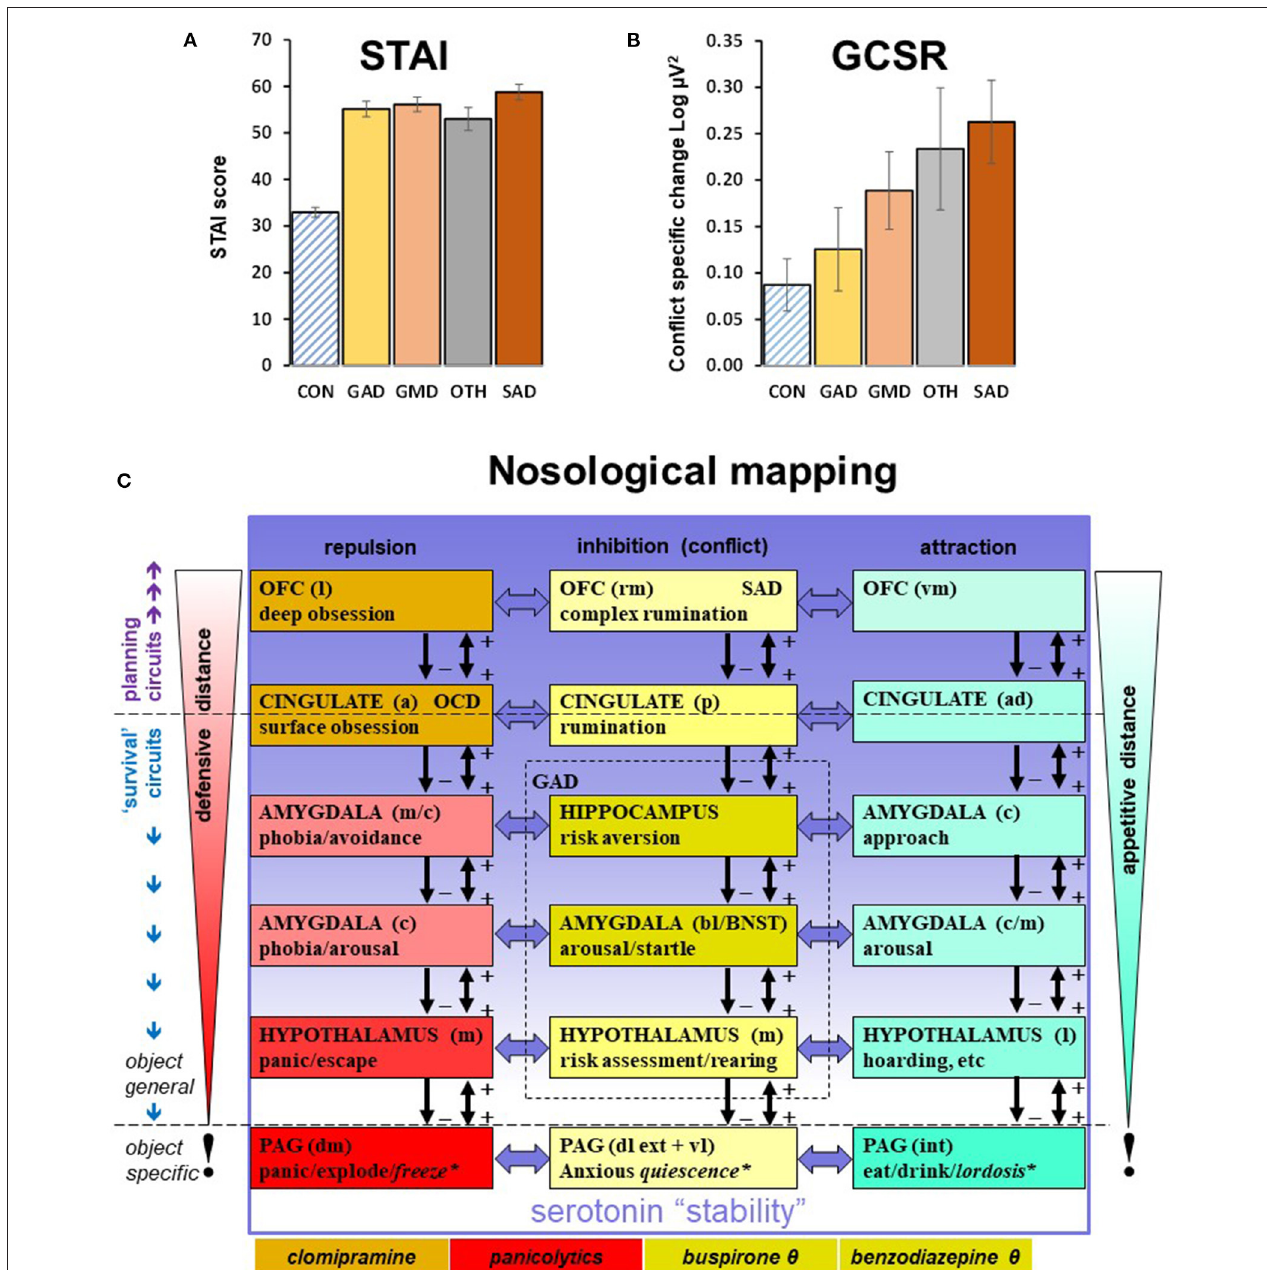
FIGURE 1 | (A) The relationship of Spielberger State Trait Anxiety Inventory (Spielberger et al., 1983) trait values (STAI) to DSM (American Psychiatric Association, 2013) diagnosis in the same groups as B. Bars are ± SEM. (B) The relationship of goal conflict specific rhythmicity (GCSR, 4–7Hz maximum value) to DSM diagnosis. The data are from (Shadli et al., 2021b) with permission of the author. Note that the trait anxiety scores are high (clinical cases are usually > 45), and very similar across the groups. GCSR appears elevated across all diagnoses but varies across the groups (there is no obvious factor controlling this variation). CON, community control; GAD, generalized anxiety disorder; GMD, GAD + major depression; SAD, social anxiety disorder; OTH, mixed other anxiety-related diagnoses with small N per diagnosis. (C) Nosological mapping to hierarchical systems. Goal attraction, goal repulsion, and goal inhibition (activated by conflict between goals) are each controlled by systems in which modules are organized hierarchically in relation to motivational distance (from contacting to distant) and neural location (caudal to rostral). Conservation of modulatory control during phylogeny (McNaughton, 2020) means that hormonal compounds, e.g., benzodiazepine receptor ligands, and neuromodulators, e.g., serotonin, can target all the modules of a specific system (as with benzodiazepines and goal inhibition; yellow highlight) or all the modules of several systems (as with serotonin). Note that in the case of serotonin (most obviously via specific serotonin reuptake inhibitors), its effects (indicated by the gradation of the purple shading) appear to be to shift control from lower to higher levels of the systems (Carver et al., 2008) rather than to increase or decrease activity across an entire system. There is also the capacity for more localized dysfunction and pharmacological specificity, as with obsession (orange highlight) and panic (red highlight).